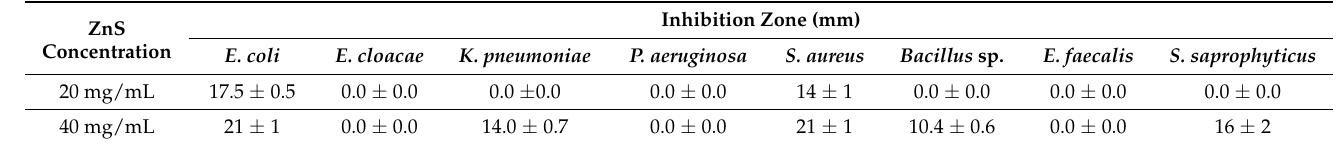
Table 2. Antibacterial inhibition zone (mm) of ZnS nanoparticles.